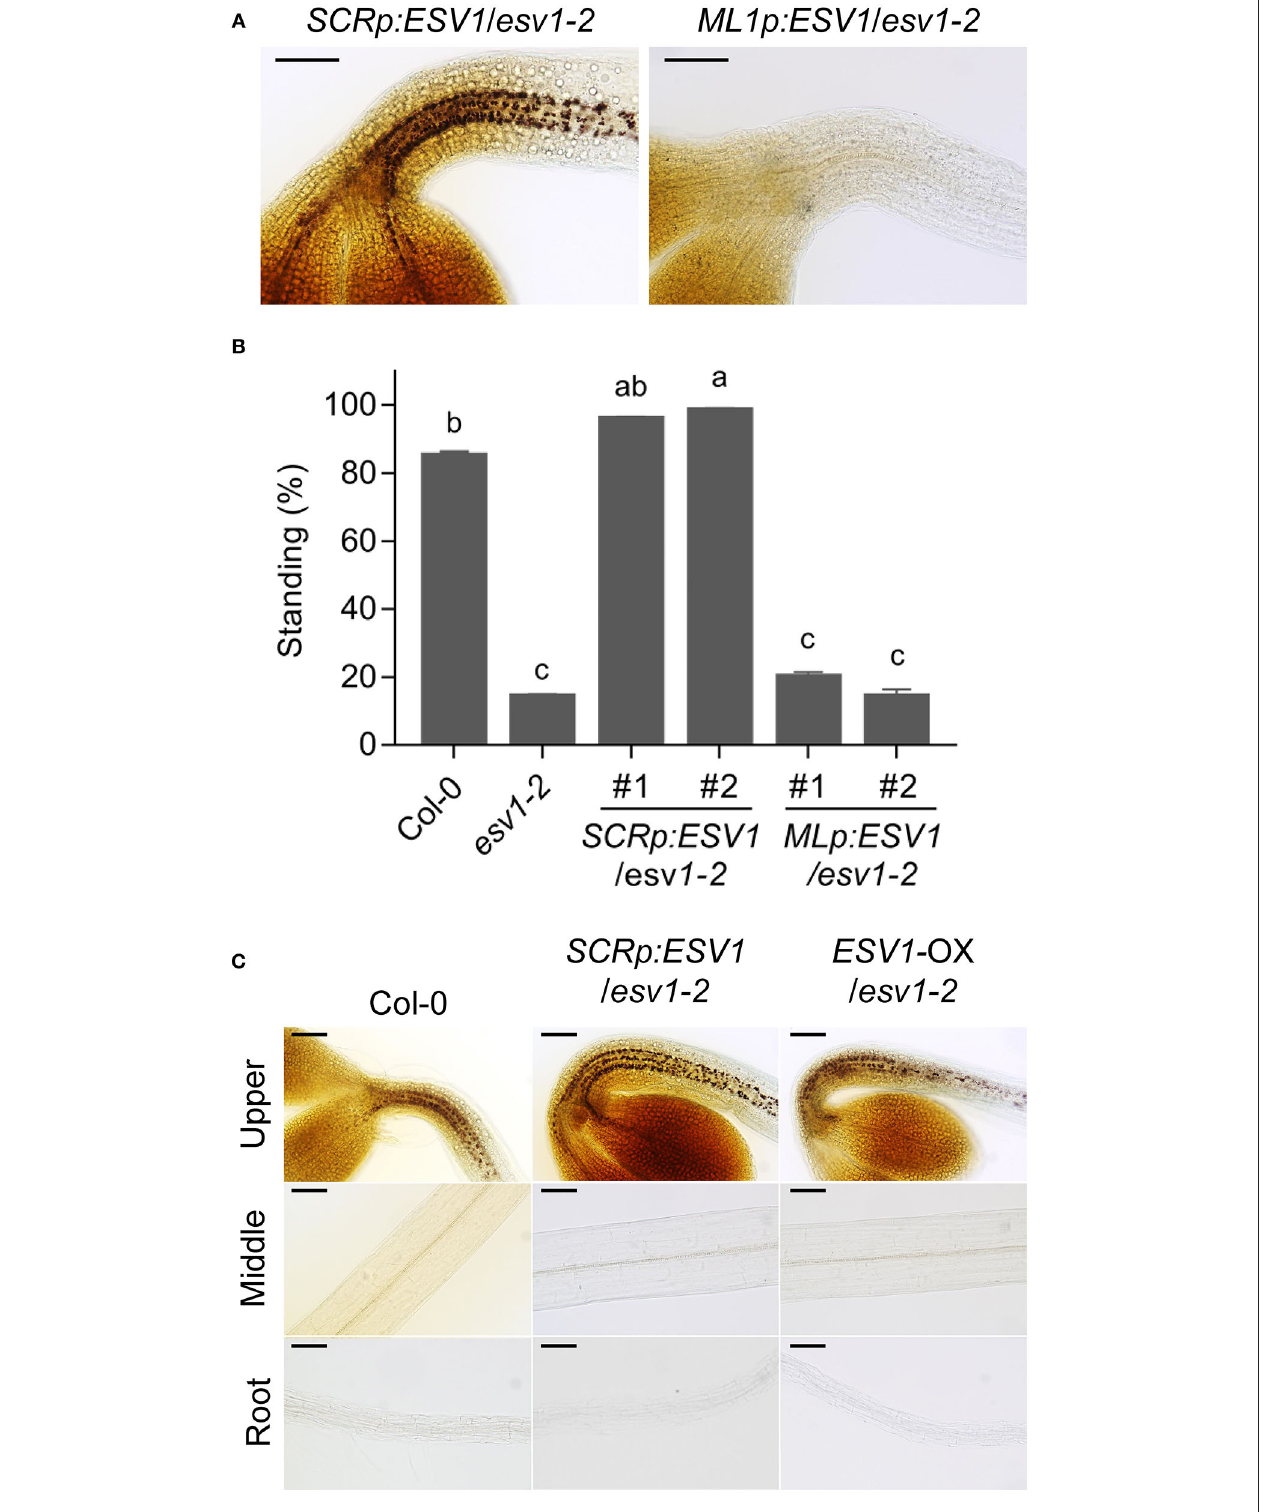
FIGURE 3 | ESV1 promotes hypocotyl negative gravitropism in the endodermis. (A) Restoration of endodermal starch granules by endodermal but not epidermal ESV1 . Endodermal starch granules were visualized by staining 3-day-old dark-grown transgenic seedlings with Lugol’s iodine. SCRp:ESV1 / ESV1-2 : transgenic